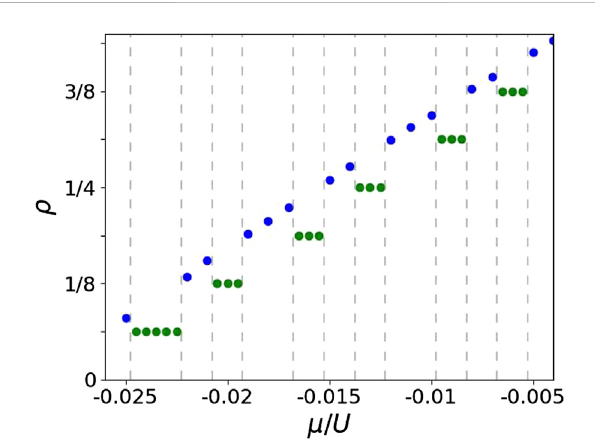
FIGURE 1 Compressibility plot: Ground state ρ as a function of μ / U at J = 0.01 U and α = 1/4. Green color dots represent the incompressible states, and the super fl uid states are identi fi ed with blue color dots. The dashed gray line is a guide to the eye, separating the super fl uid and incompressible state regimes. This plot is obtained using the CGMF methodwiththe4×4clusterfora12×12latticewithpbcalongboththe directions.